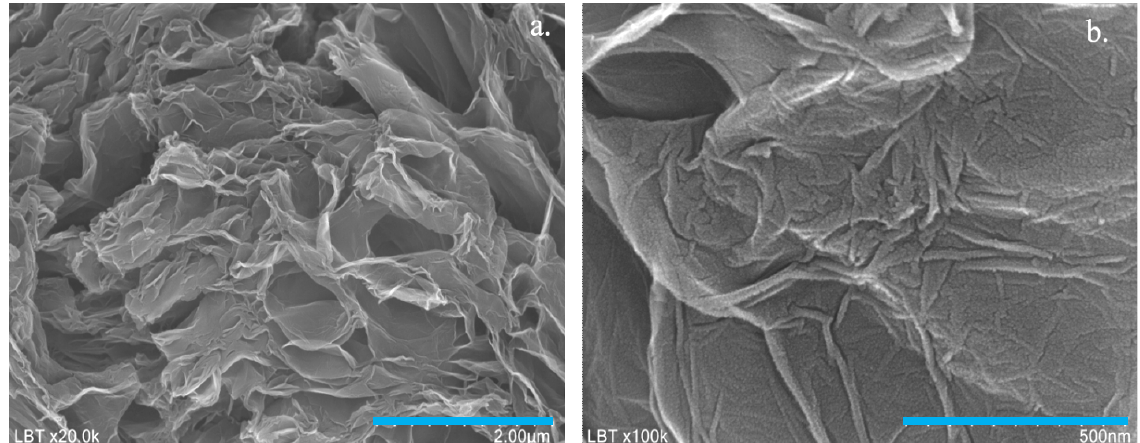
Figure 1. SEM micrographs with different magnifications of N,B-co-doped graphene sample; scale bar 2 µ m ( a ); 500 nm ( b ).